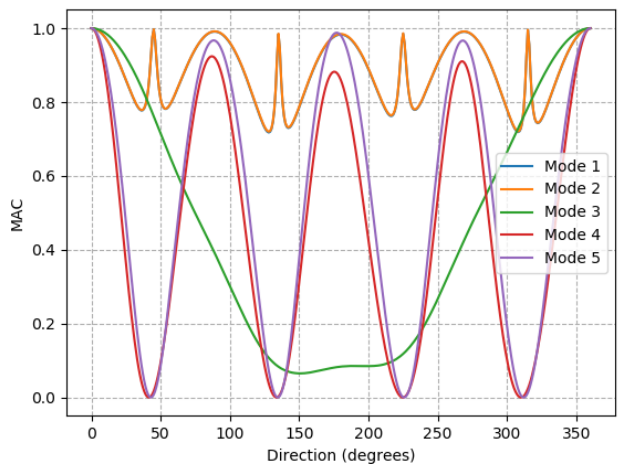
Figure 5. Modal assurance criterion (MAC) values for the undamaged case as nacelle direction is rotated in comparison to 0 degrees. Comparison is made to the original direction at 0 degrees. Mode shapes are transformed to the original reference.